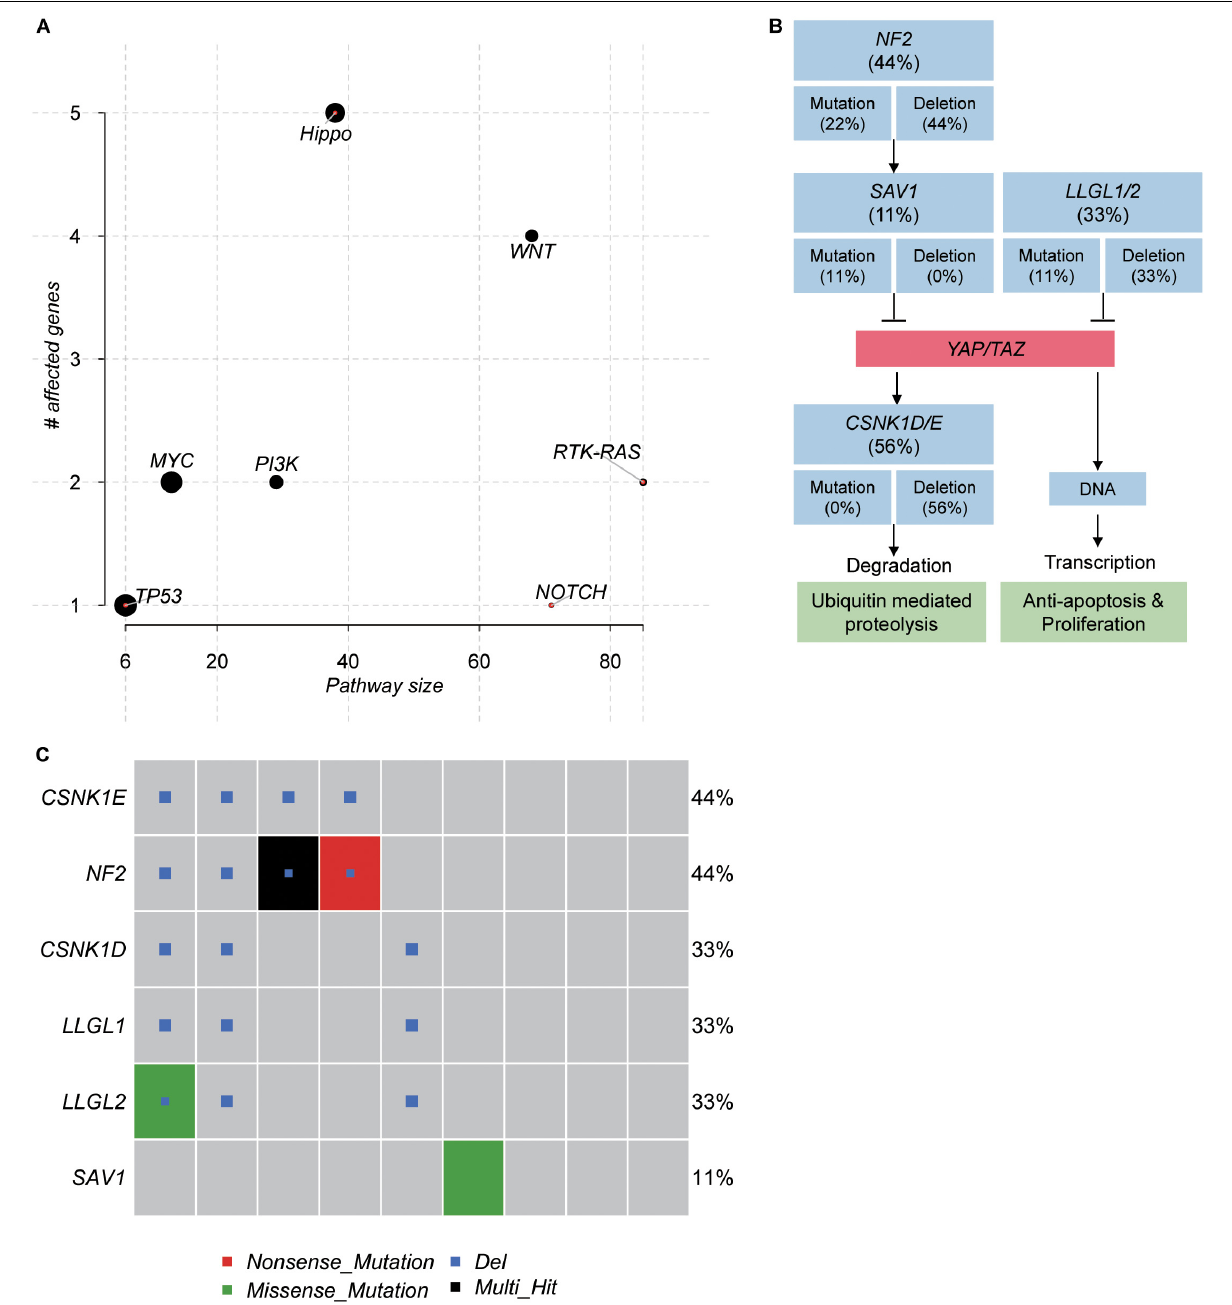
signaling pathway has been widely reported to be implicated in schwannoma by previous studies (Nikuseva-Martic et al., 2007; Oh et al., 2015; Brodhun et al., 2017; Zhao et al., 2018). SAV1 promotes activation of MST-LATS kinase cascade in Hippo signaling, which suppresses the activities of YAP/TAZ by